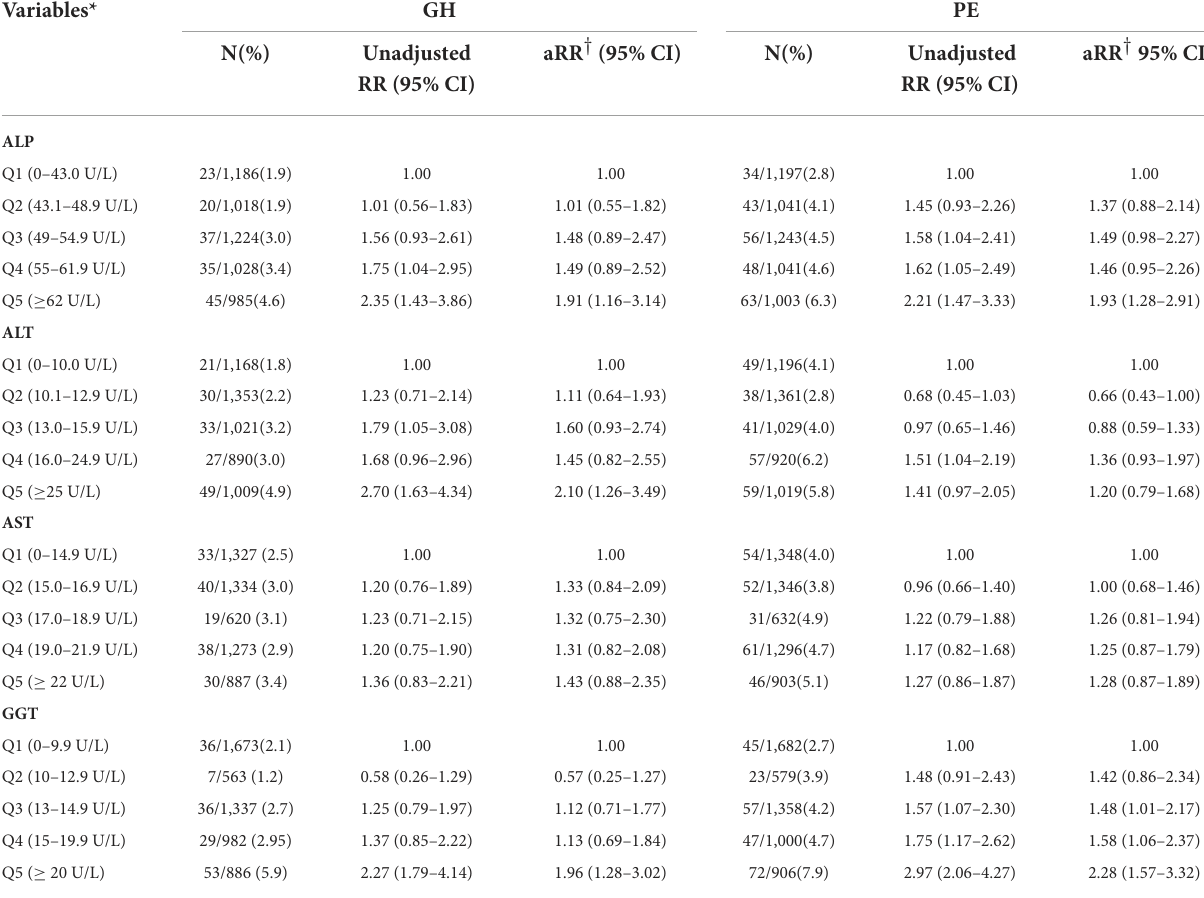
TABLE 2 Associations of quintiled liver enzyme levels in early pregnancy with risk of GH and